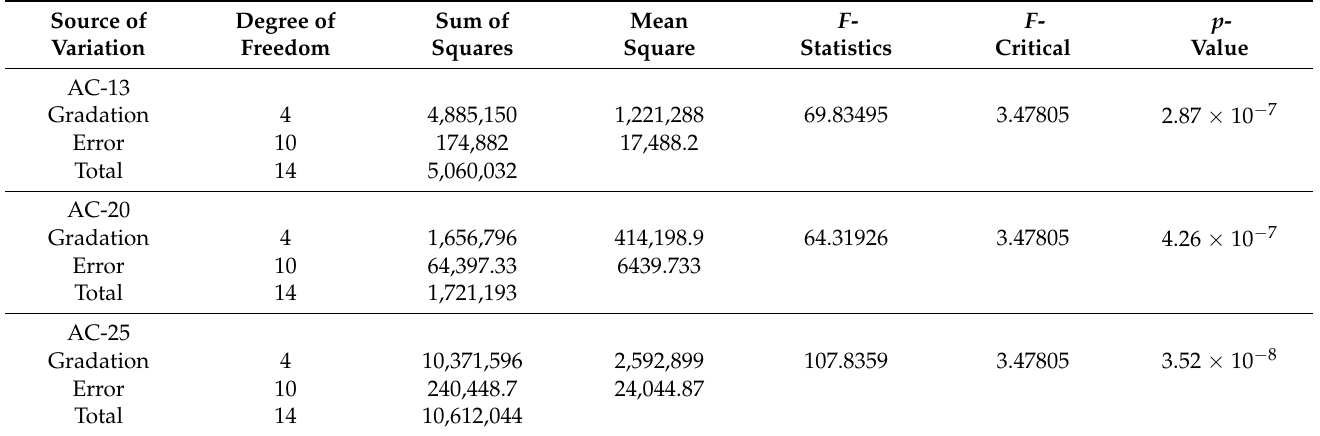
Table 6. ANOVA results for the DS of AC